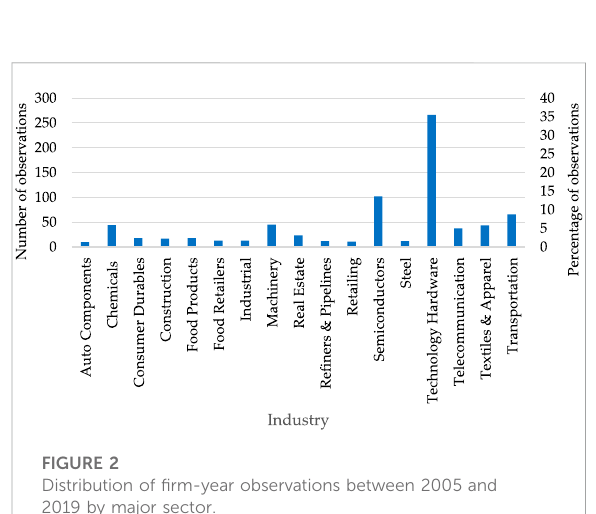
FIGURE 2 Distribution of fi rm-year observations between 2005 and 2019 by major sector.